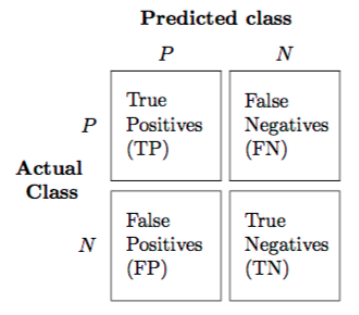
Figure 6. Confusion